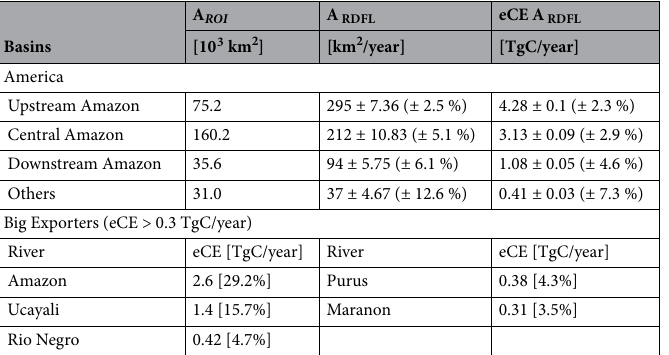
Table 1. Estimates of Eco-morphodynamic Carbon Export (eCE) and River-Driven Forest Loss Area ( A RDFL ) for the largest tropical rivers. Values in parentheses indicate the percentage error while values in square parentheses are the percentage relative to total eCE = 8.9 Tg C/year. Uncertainty analysis is described in